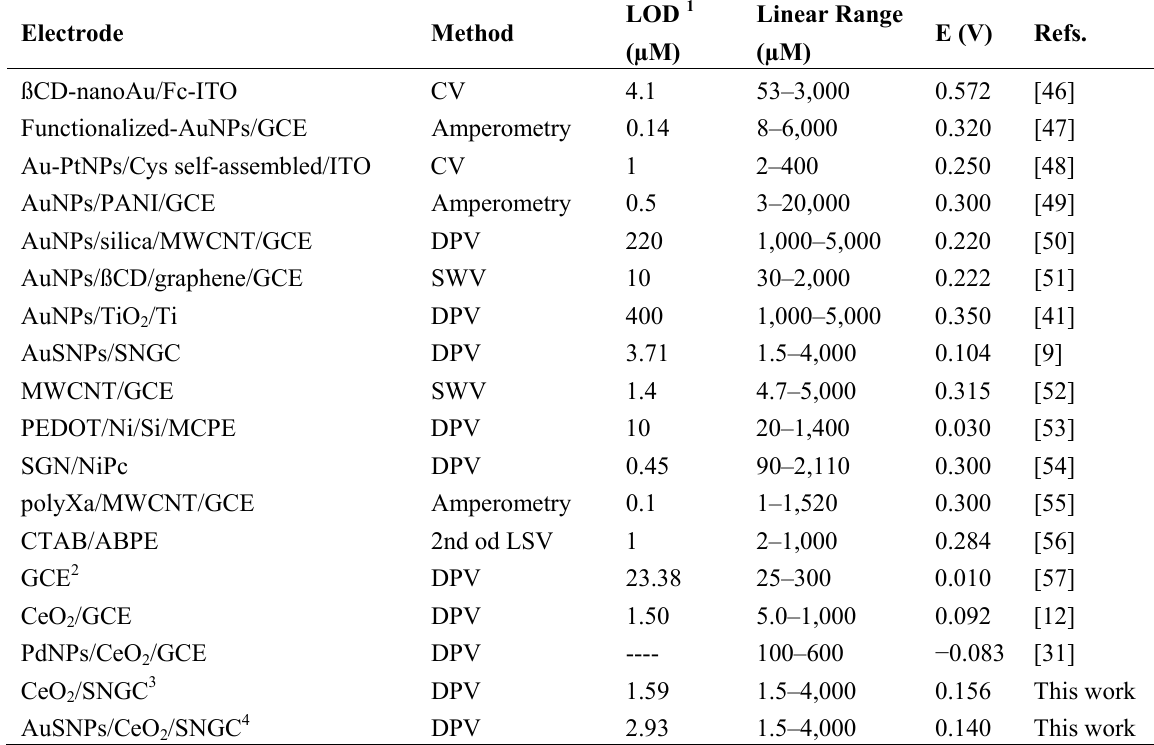
Table 4. Comparison of different CeO for AA